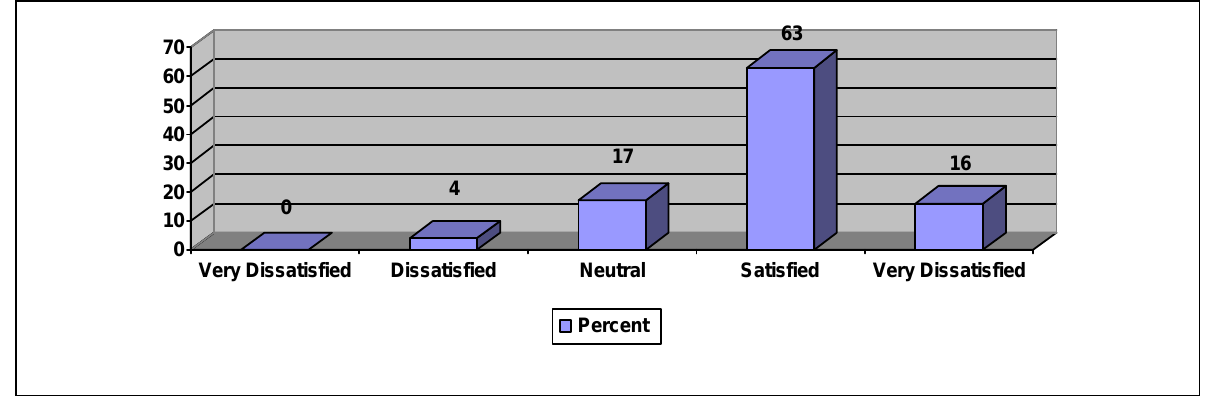
Job satisfaction levels of respondents at the time of